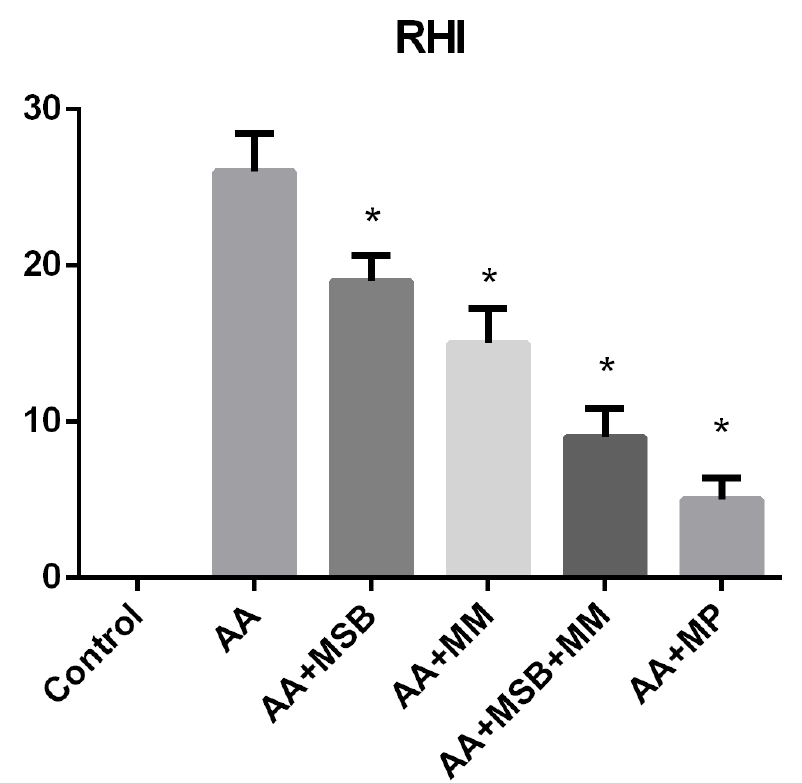
Figure 11. Robarts Histopathology Index. Robarts Histopathology Index was assessed by scoring for each animal the most affected area. Control samples were normal, with an index of 0, while AA samples had a mean score of 26. AA + MSB scored a mean of 19, AA + MM a mean of 15, AA + MSB + MM a mean of 9, and AA + MP a mean of 5. * p < 0.05 compared to AA. Abbreviations: RHI, Robarts Histopathology Index; AA, 4% acetic acid; MSB, MegaSporeBiotic ™ ; MM, MegaMucosa ™ ; MP, methylprednisolone. The bars represent mean values with standard